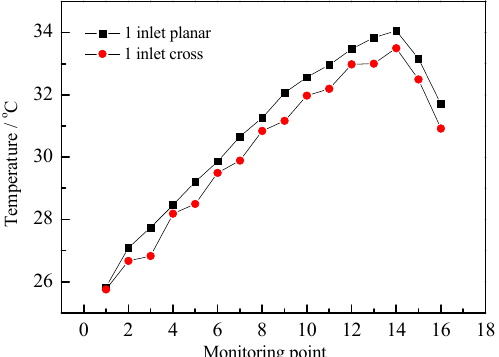
Figure 6. Comparison of temperature rising with planar and cross arrangement sat the rate of 1.0 m/s at 25 °C and 1C discharging rate.